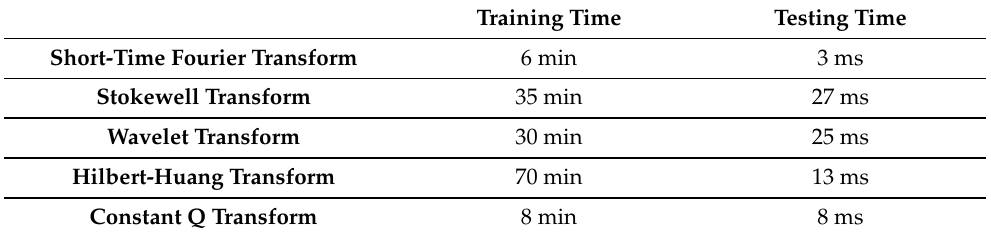
Table 3. Computational burden of the proposed